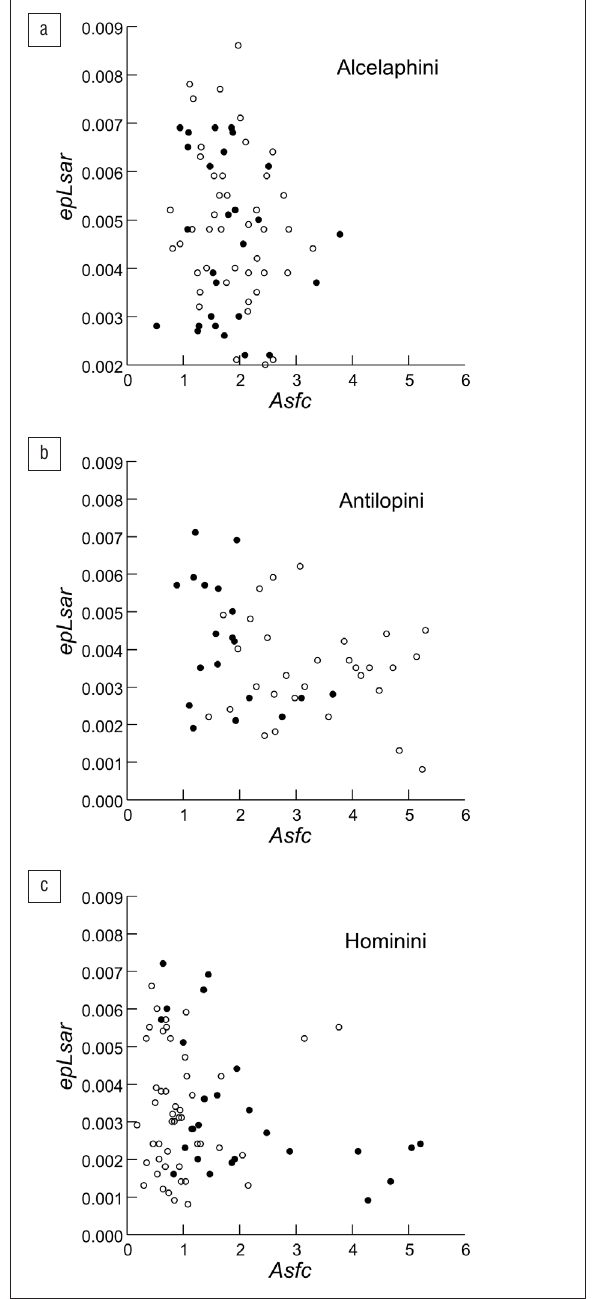
Figure 2: Anisotropy ( epLsar ) versus complexity ( Asfc ) plots for the fossil (a) Alcelaphini, (b) Antilopini and (c) Hominini. Eastern African specimens are clear and southern African ones are solid. Figure 3: Anisotropy ( epLsar ) versus complexity ( Asfc ) plots for the Original data for all individual specimens are presented in fossil (a) Alcelaphini and (b) Antilopini compared with baseline Appendix 1 in the supplementary material. specimens, with diets as indicated in the legend (extant bovid data from Scott 29 ). The space represented by eastern African fossil specimens is depicted by the red polygon, whereas Mean (s.d.) for microwear attributes by tribe and location that represented by the southern African fossil specimens is depicted by the blue polygon. The polygons were constructed Eastern Southern by connecting the farthest separated data points on both axes. Asfc epLsar n Asfc epLsar n In sum, while grit undoubtedly impacts tooth wear 9,13,14 , the lack of a consistent location signal among the tribes suggests that differences in microwear between eastern and southern African hominins are likely not a result of abrasive load alone. Diet remains the most plausible explanation for the variation in dental microwear among